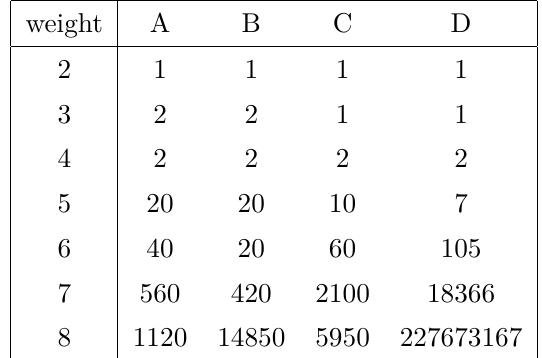
Table 3 . The sizes of maximal entries of the coproduct tensors c ( p ) computational setups that we used. The version A, our best choice so far, reorders the rows of the tensors and uses the LLL reduction; the version B in addition to that also rescales the rows of the tensors in order to make them integer-valued and only then applies the LLL; the version C only uses the LLL without any reordering of the rows; version D does not modify the tensors in any way and serves as a baseline for numeric